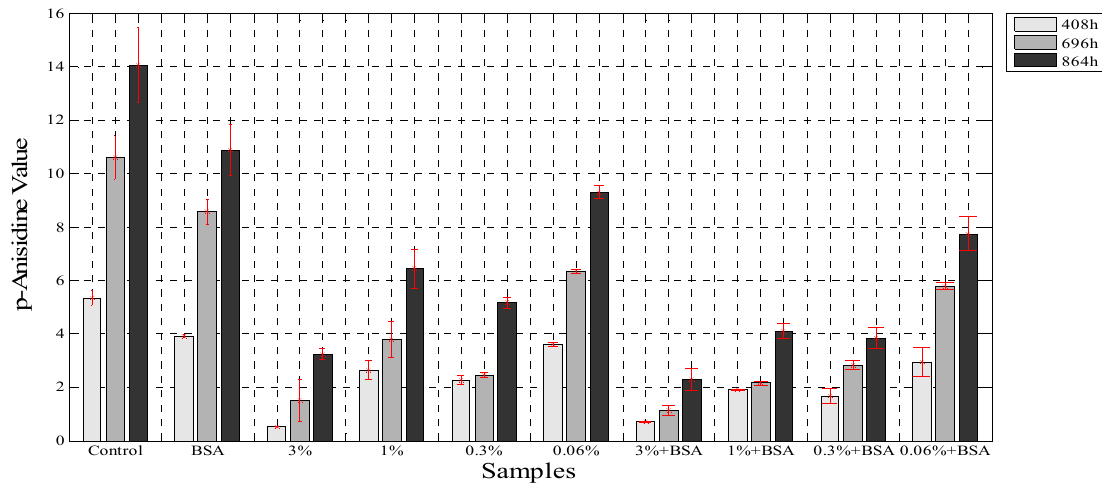
Figure 5. The p -anisidine values for the samples with BSA and without